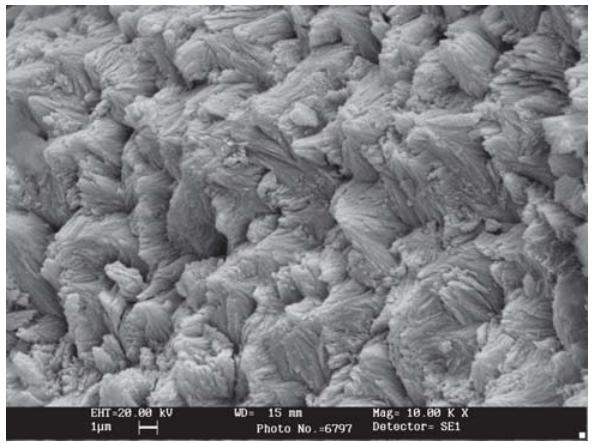
FIGURE 3- Fractured enamel surface of bleached specimens with 10% carbamide peroxide stored in artificial saliva. Porosities are seen on the surface of transversally fractured prisms (arrowheads)